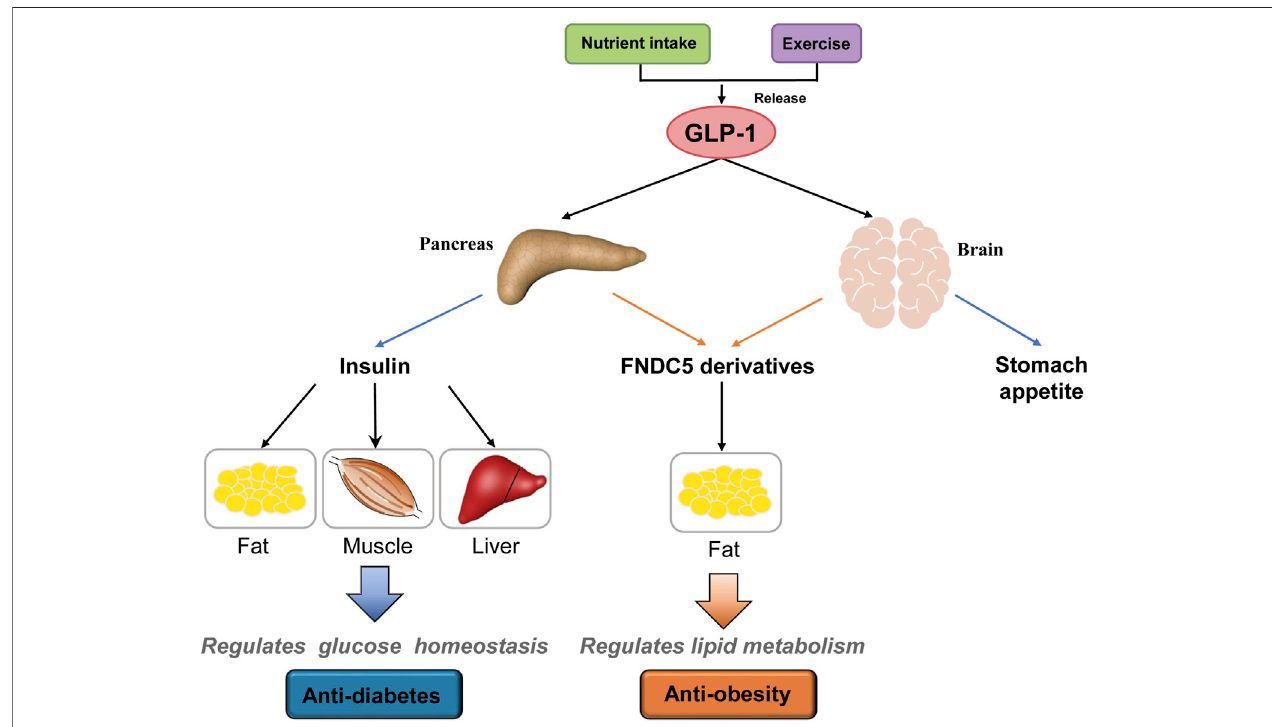
FIGURE 7 | A proposed model of GLP-1 ’ s anti-diabetes and anti-obesity actions. GLP-1 is produced after food intake and/or exercise and acts on the pancreas, brain,andotherresponsiveorgans.Inthepancreas,GLP-1inducesthereleaseofinsulinthatthenregulatesglucosehomeostasisthroughitsactionsonfat,muscle,and liver. On the other hand, GLP-1 induces the secretion of FNDC5 derivatives (e.g., sFNDC5 and irisin) from the pancreas and brain that regulate lipid metabolism in adipose tissue. GLP-1 also suppresses appetite through its action on the brain. Other potential organs involved in GLP-1 actions are not shown.